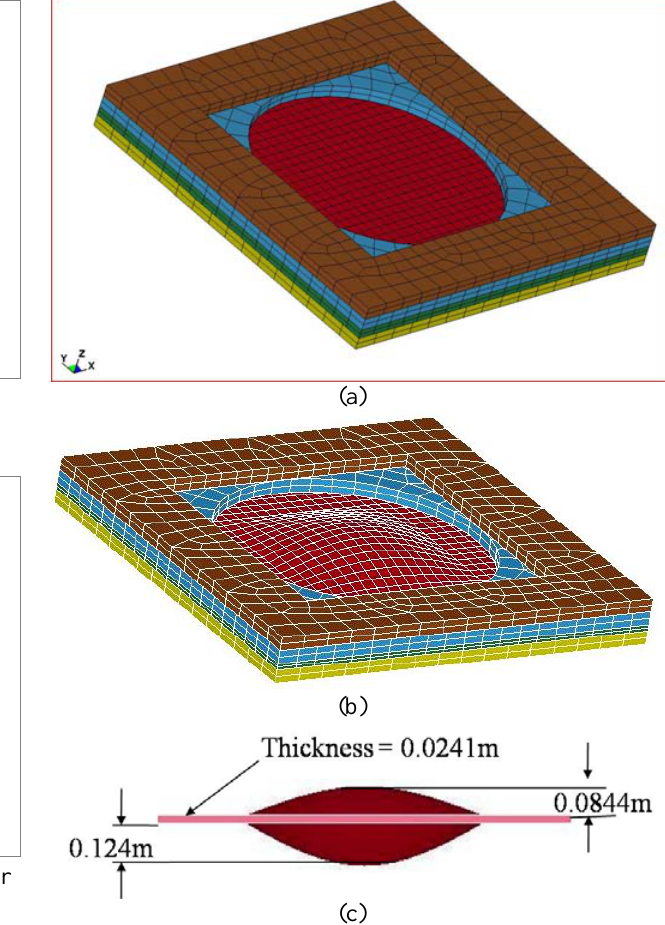
Fig. 13. (a) Baseline design (uniform thickness) (b) Opti- mized plate-double bulge (for large envelope case) (c) Op- timized plate dimensions = 32, n = 10 Table 4. Parallel computation for 3 DV, n pop gen